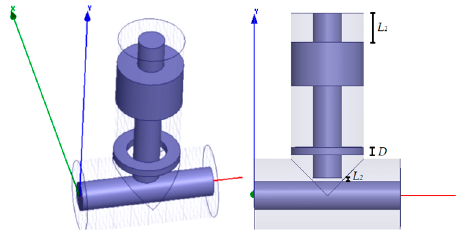
Figure 8. Schematic of the fully coaxial equalizer substructure design.